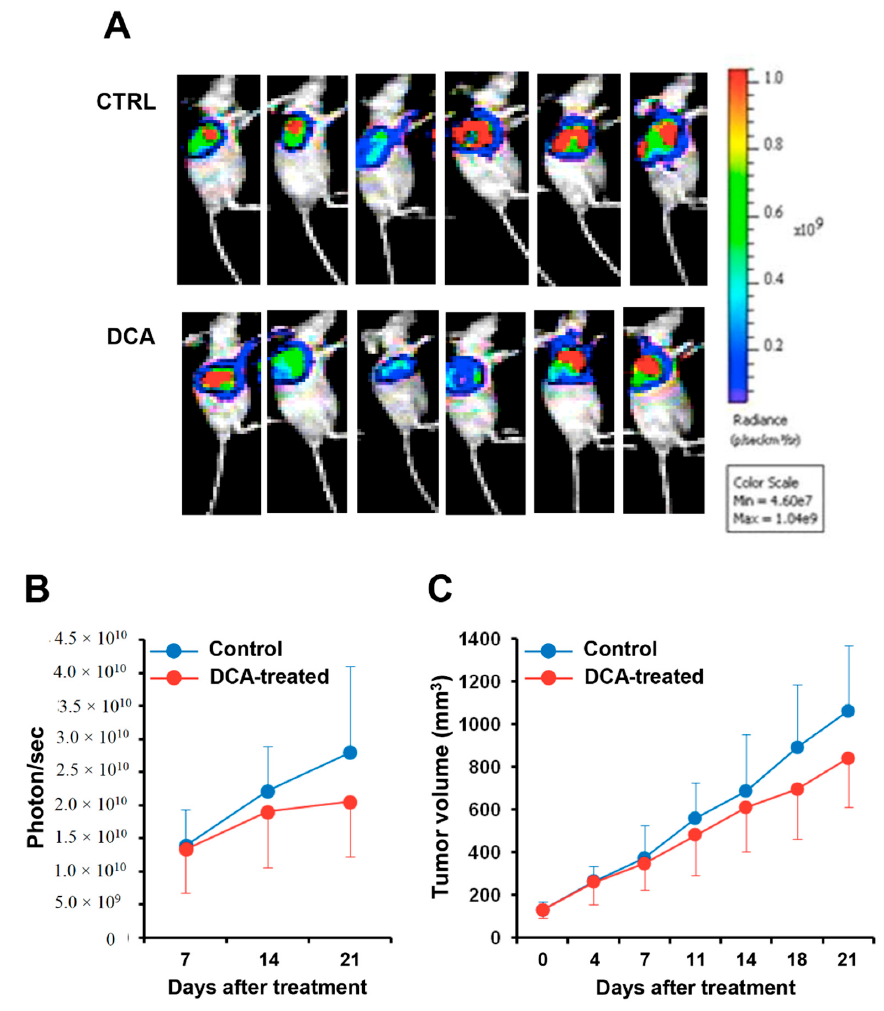
Figure 9. In vivo effect of DCA on PDAC tumor. Bioluminescence signaling was measured as photons/sec in CTRL group 1 receiving normal saline, i.p., qw, and in DCA group 2 receiving DCA ( A , B ). The tumor masses were harvested and the tumor volume was measured ( C ). See Materials and Methods for details.